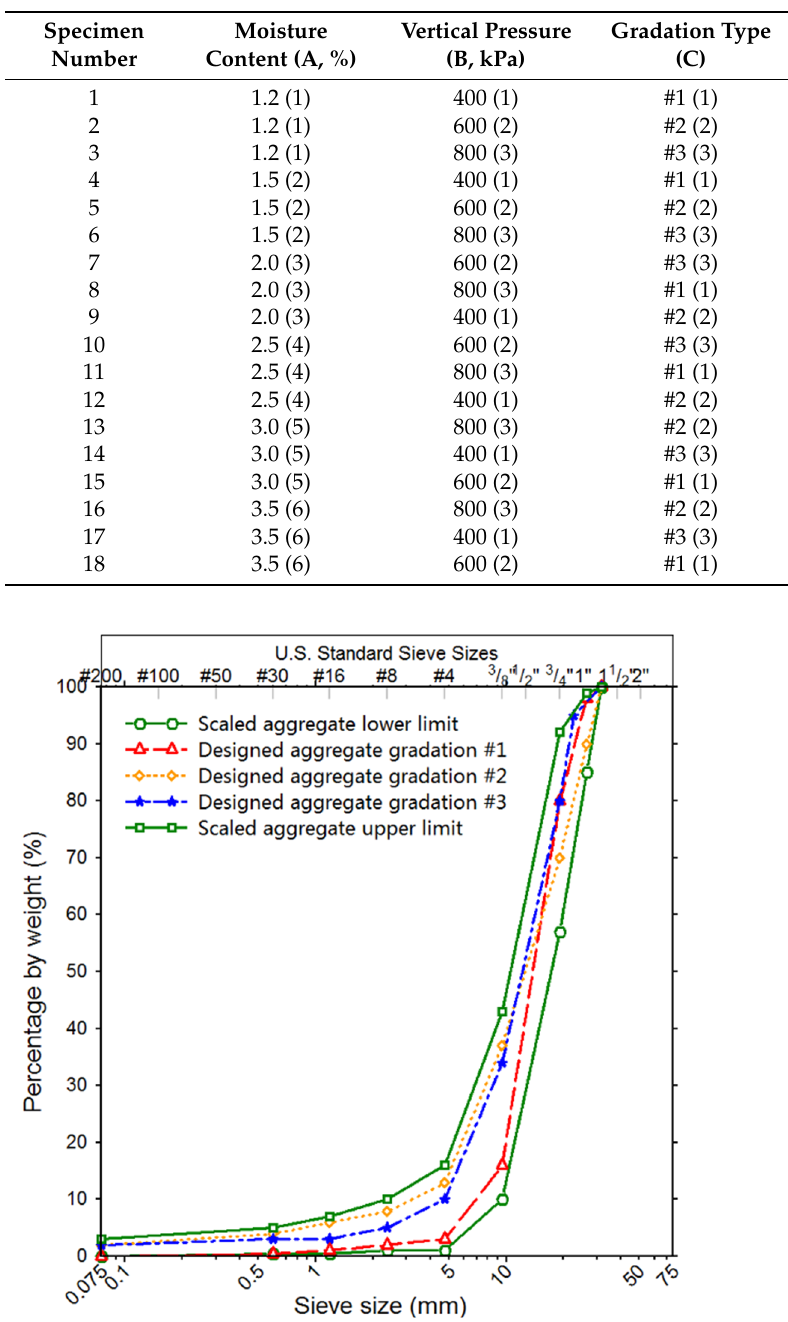
Table 1. The orthogonal design scheme for laboratory gyratory compaction testing.